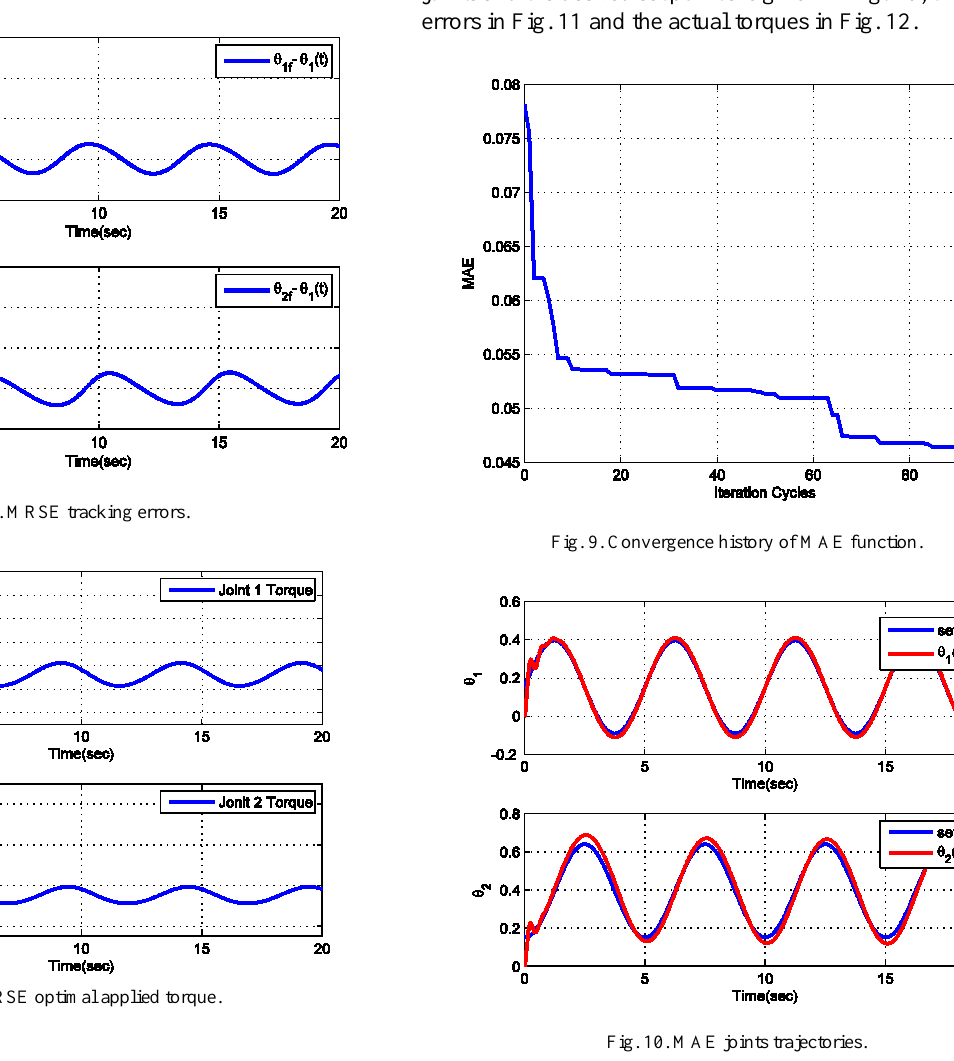
Fig. 5. MRSE joints trajectories.